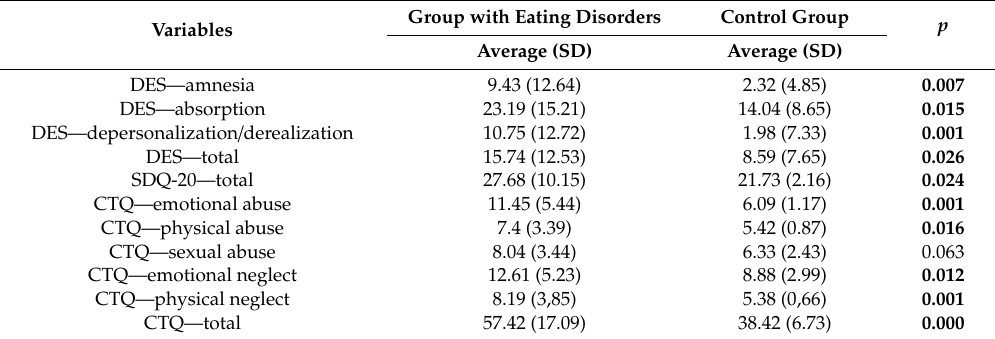
Table 2. Di ff erences between the group of participants with eating disorders and the control group as regards the variables: childhood trauma, psychoform dissociation and somatoform